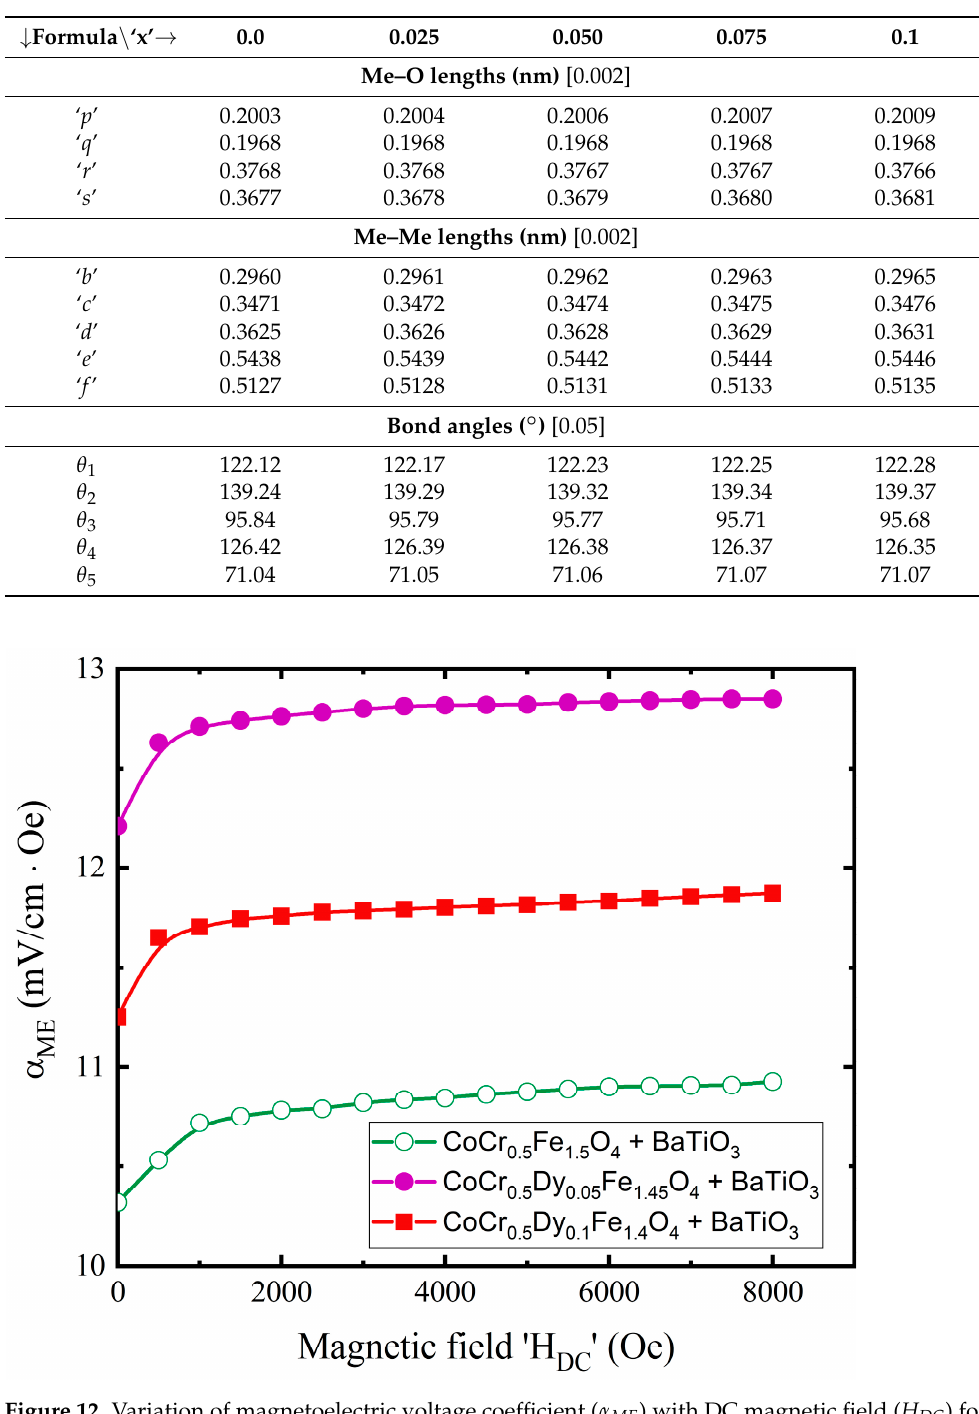
Table 8. Inter-ionic lengths (Me–O, Me–Me) and bond angles ( θ ) of CoCr 0.5 Dy x Fe 1.5 − x O 4 . Figures in the square bracket refers to the estimated error.